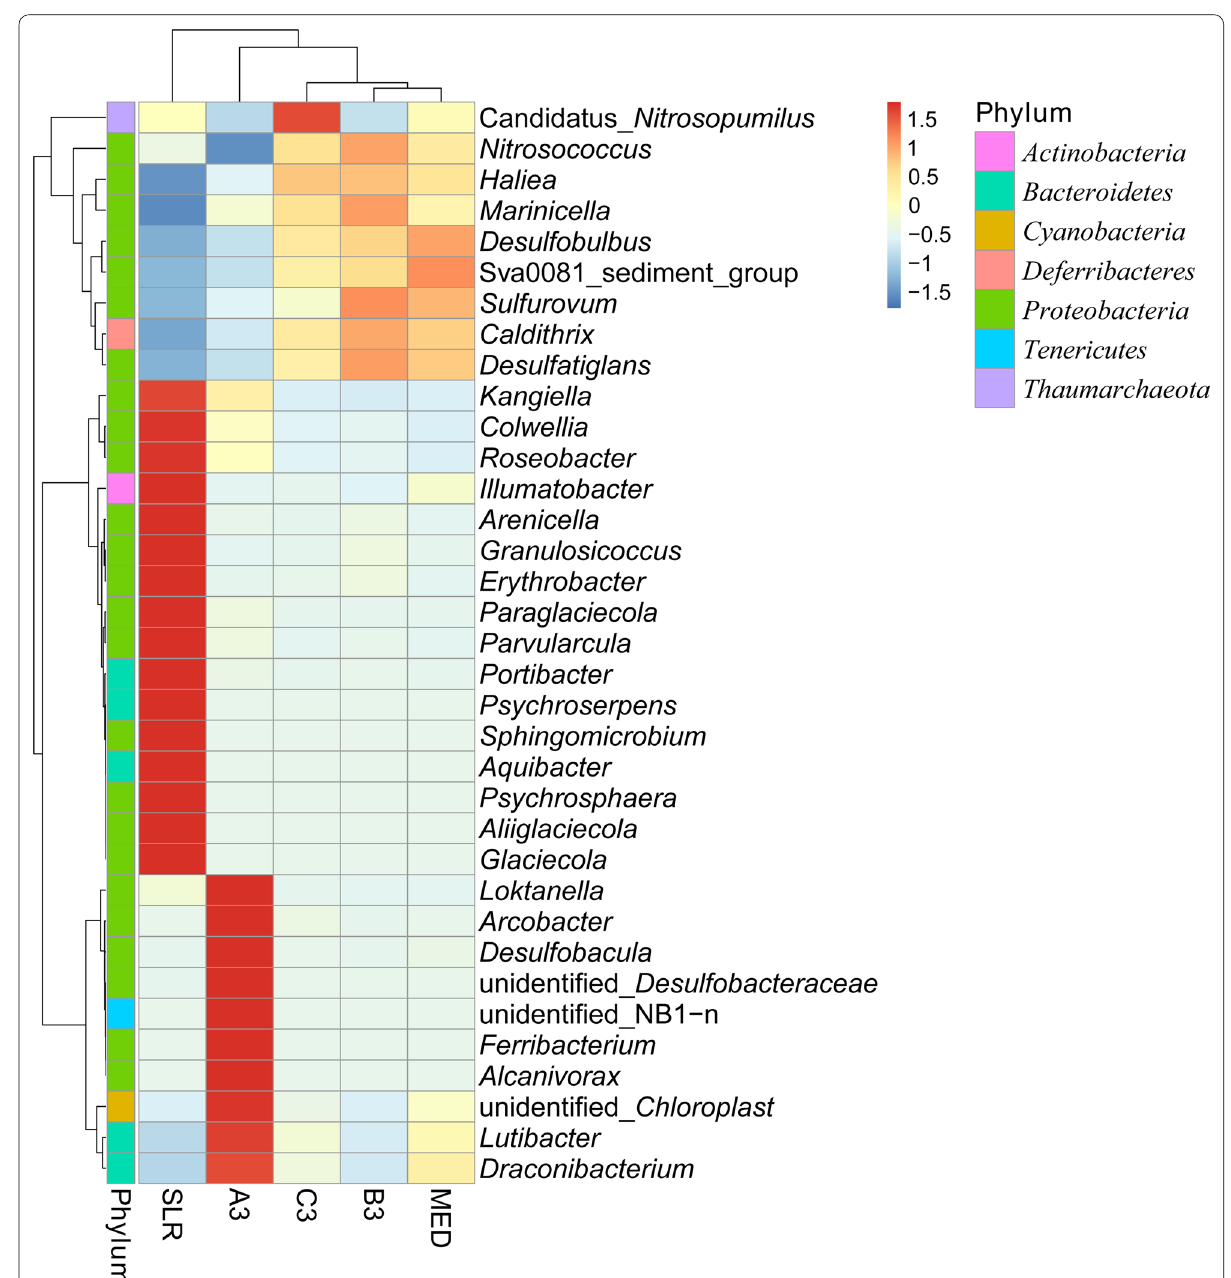
Fig. 6 The heatmap analysis of the sediments in the direction perpendicular to the shoreline. The analyses were generated from the abundance data at the genus level. The top 35 genera were selected. The symbol A3 (B3, C3): the sampling site near the leak point; MED: control site in Jiaozhou Bay; SLR: control site outside of Jiaozhou